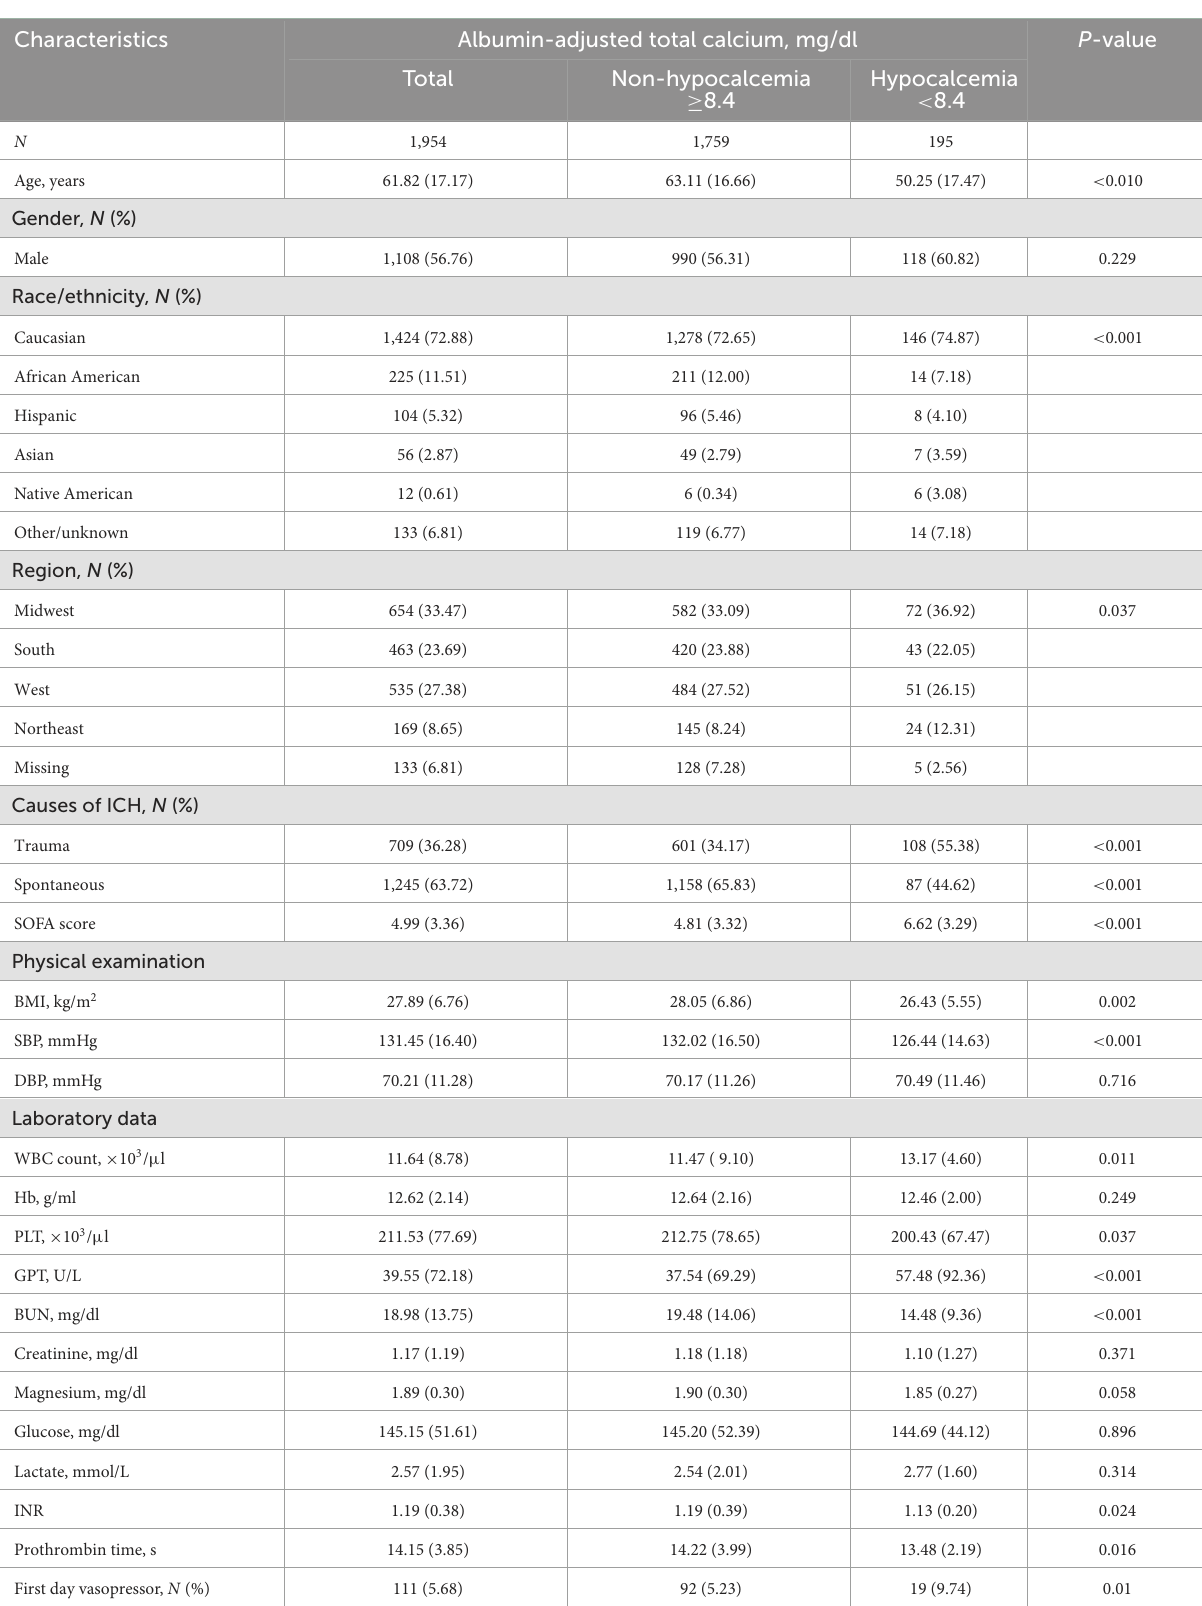
TABLE 1 Characteristics of study